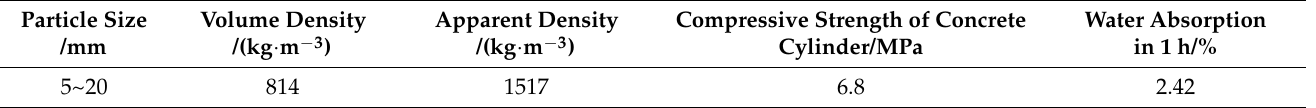
Table 1. Physical properties of shale ceramsite.